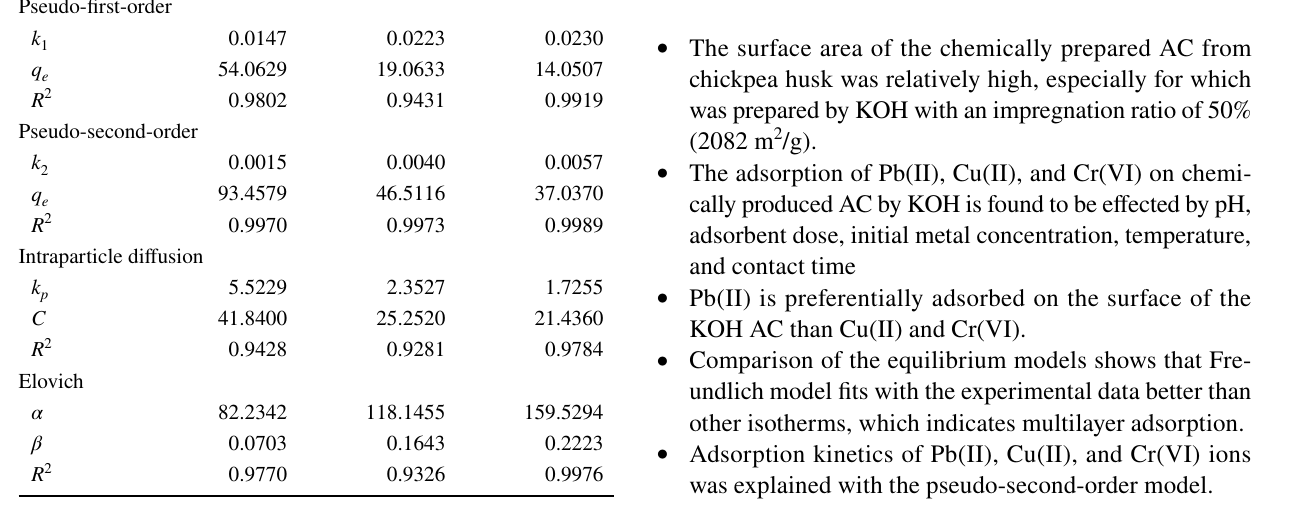
Table 5 Kinetic parameters calculated at 20 °C and 400 mg/L initial metal concentration Kinetic model